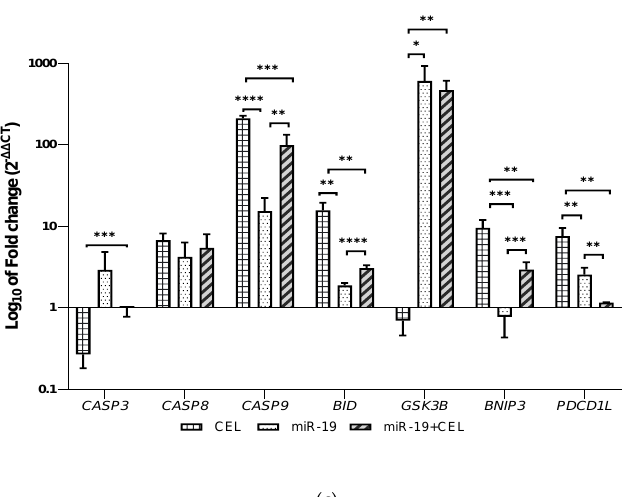
Figure 4. RT-qPCR analysis for the genes related to apoptosis after 24 h of treatment with 1 µ M celastrol, 0.25 nM miR-9-2, miR-17, miR-19 specific siRNA (miR-9-2, miR-17, miR-19) and the combination of celastrol with the knockdown of miR-9-2 , miR-17 miR-19 genes (miR9-2 + CEL, miR-17 + CEL and miR-19 + CEL) is presented as the fold change (2 −∆∆CT ) in the level of their expression, which was normalized to the TBP reference gene. C (control) untreated cells. The data are expressed as the mean ± SD ( n = 6 independent assays); statistically significant * p < 0.05, ** p < 0.01, *** p < 0.001, **** p < 0.0001, ordinary one- way ANOVA followed by a post hoc Tukey’s test. ( a ) The U251MG cells that had been exposed to celastrol ( 1 μ ; CEL) for 24 h, the siRNA that is specific for miR-9-2 (0.25 nM; miR-9-2) for 48 h or a combination of the siRNA specific for miR-9-2 (0.25 nM) for 48 h and celastrol ( 1 μ ) for 24 h (miR-9-2 + CEL). ( b ) The U251MG cells that had been exposed to celastrol ( 1 μ ; CEL) for 24 h, the siRNA that is specific for miR-17 (0.25 nM; miR-17) for 48 h or a combination of the siRNA that is specific for miR-17 (0.25 nM) for 48 h and celastrol ( 1 μ ) for 24 h (miR-17 + CEL). ( c ) The U251MG cells that had been exposed to celastrol ( 1 μ ; CEL) for 24 h, the siRNA that is specific for miR-19 (0.25 nM; miR-19) for 48 h or a combination of the siRNA that is specific for miR-19 (0.25 nM) for 48 h and celastrol ( 1 μ ) for 24 h (miR-19 + CEL). Table 4. Results of the one-way ANOVA followed by the post-hoc Tukey test in Figure 3. Statisti- cally significant * p < 0.05, ** p < 0.01, *** p < 0.001, **** p < 0.0001.